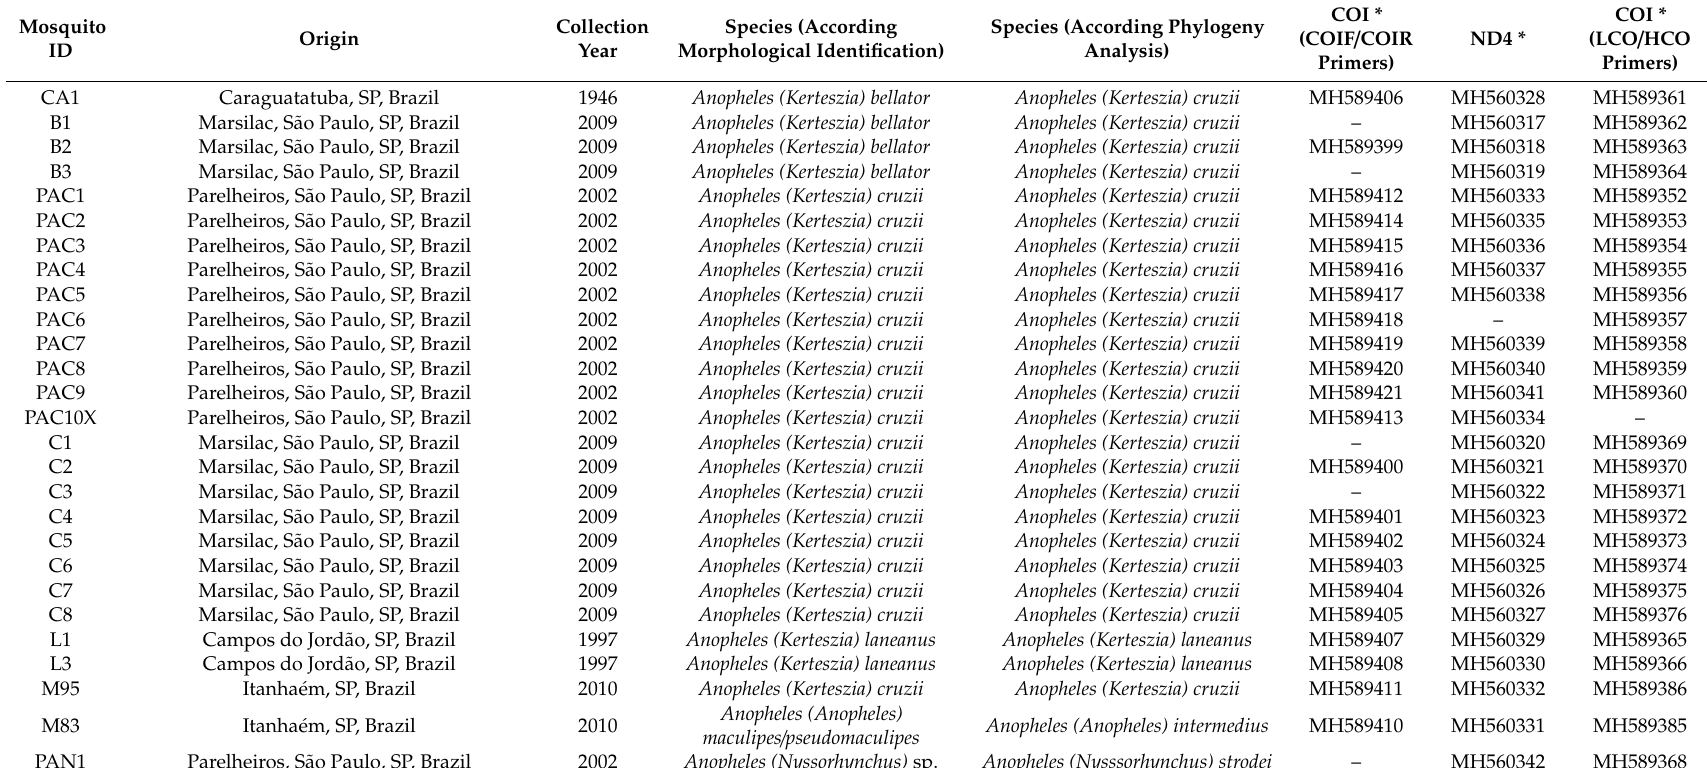
Table 2. Main features of the specimens from Brazil used in this study and GenBank accession